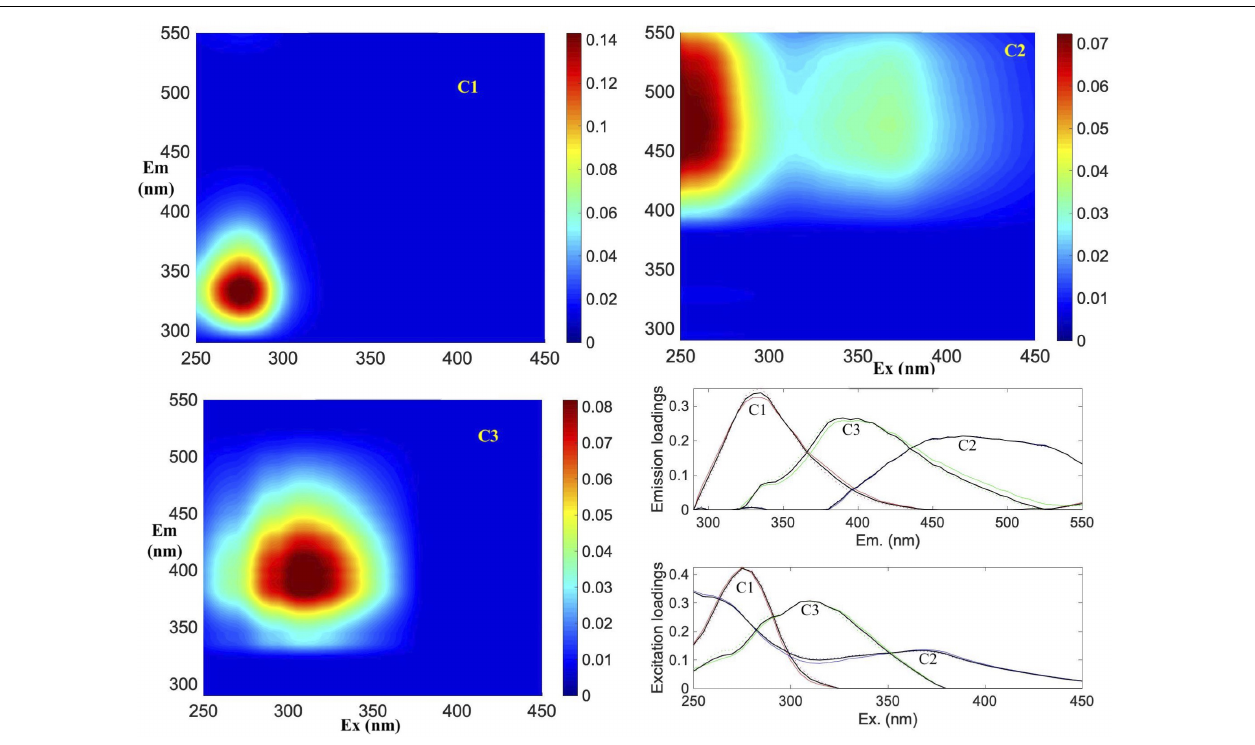
FIGURE 8 | Parallel factor analysis (PARAFAC) components. Spectral characteristics of three fluorescent components (C1, C2, and C3) identified by PARAFAC analysis. Figures show the EEMs plots of individual components in Raman Units (RU) of intensity. Excitation and emission loadings derived from the three-component PARAFAC model using split-half validation technique (bottom right). Positions of their excitation/emission maxima wavelengths are: C1 (275/335 nm), C2 ( < 260(370)/480 nm) and C3 (305/400 nm),